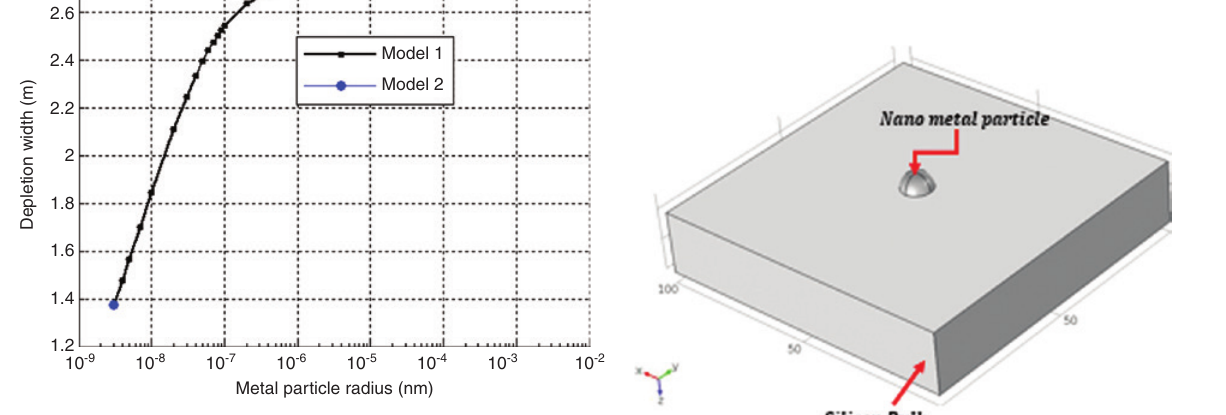
Figure 6: A schematic showing the changes in the depletion width of nano-Schottky junction for a high n-doped substrate as the metal particle radius increases.